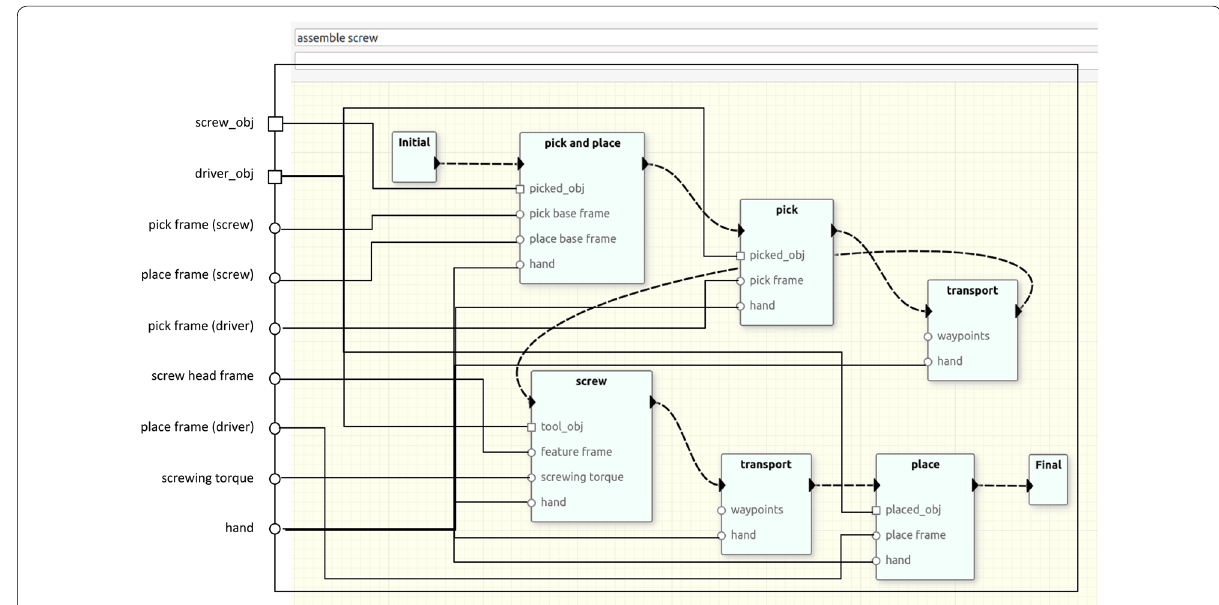
Fig. 16 Sub state machine for assembling a screw